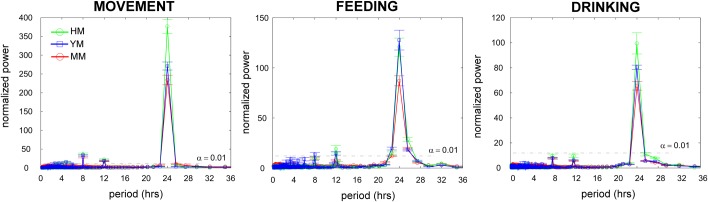
Day-to-day correspondence of activity. Humanized male mice (HM) have the least day-to-day variance in patterns of movement, feeding, and drinking. Lomb-Scargle periodograms demonstrate significant periodicities (peaks above the α=0.01 line), as well as group differences between HM, young male (YM), and middle age (MM) mice (green, blue, red traces respectively). Bars are ±one standard error of the mean.